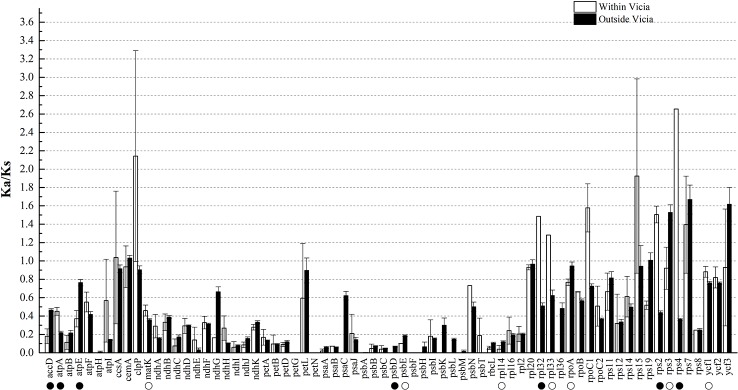
The Ka/Ks ratios of homologous protein-coding genes within and outside of the genus Vicia with V. sepium as the reference. White boxes represent the mean Ka/Ks values within the genus Vicia, and black boxes indicate the mean Ka/Ks values outside of the genus Vicia. The data are the arithmetic mean ± SE. Symbols under the gene names indicate levels of statistical significance between the species within Vicia and the species outside of Vicia: no symbol, P > 0.05, blank circle, P = 0.01–0.05; black circle, P < 0.01. The X-axis denotes the homologous genes.